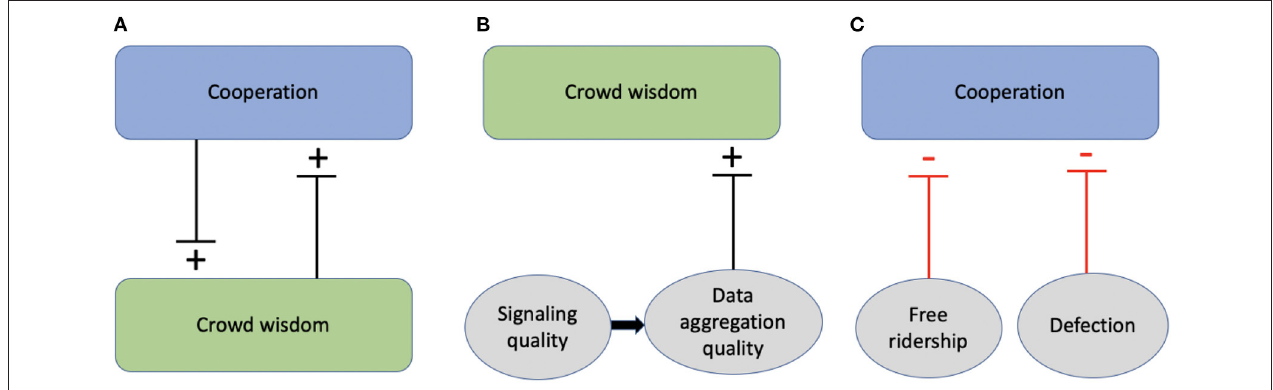
FIGURE 2 | Interactions between cooperation and crowd wisdom in collective action. (A) High cooperation and crowd wisdom can potentially facilitate each other. (B) Crowd wisdom (Galton, 1907) depends on signal quality and also on how data are aggregated and weighted. (C) Cooperation is adversely affected by free-ridership (Marwell and Ames, 1979) and defection (Mao et al., 2017).